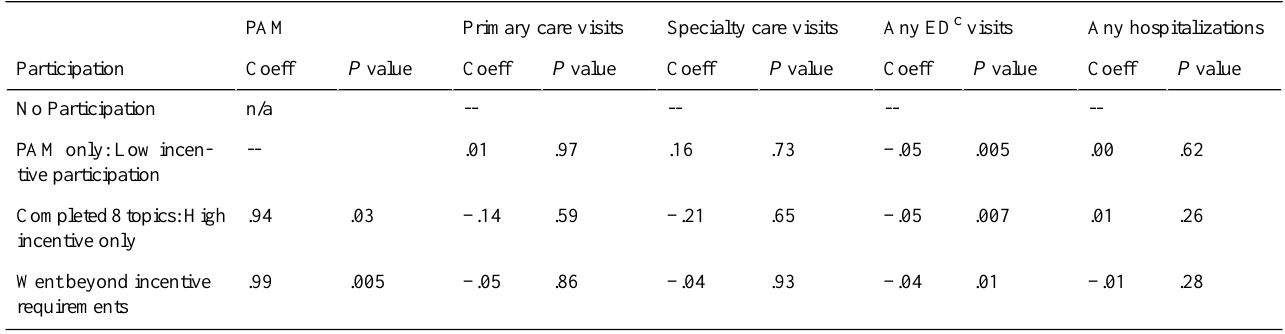
Table 5. Key regression coefficients from models examining follow-up PAM a and health care utilization, by participation status. b